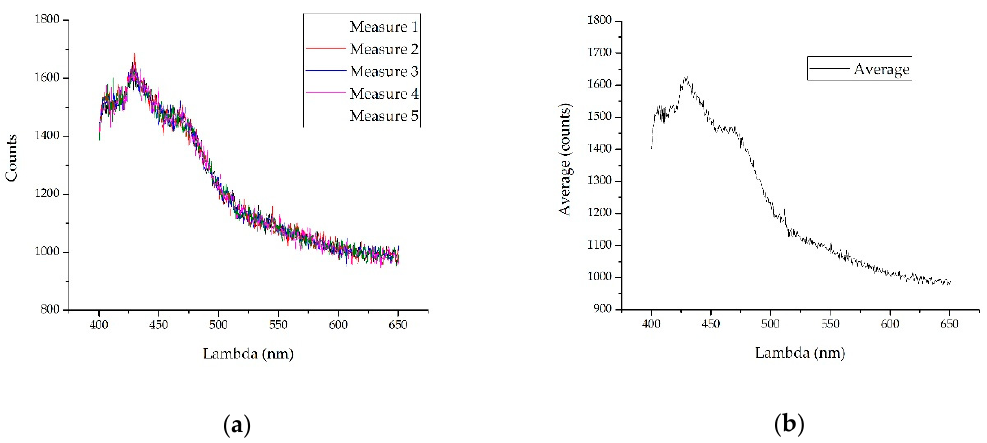
Figure 2. To illustrate noise reduction using the average of five measurements, the measurements made with the lowest current are shown, since proportionally the noise will be greater: ( a ) The five overlapping measurements are shown. Note a floor of approximately 1000 counts; ( b ) performing the average in the five samples, the noise obtained was lower than in any of the measures.